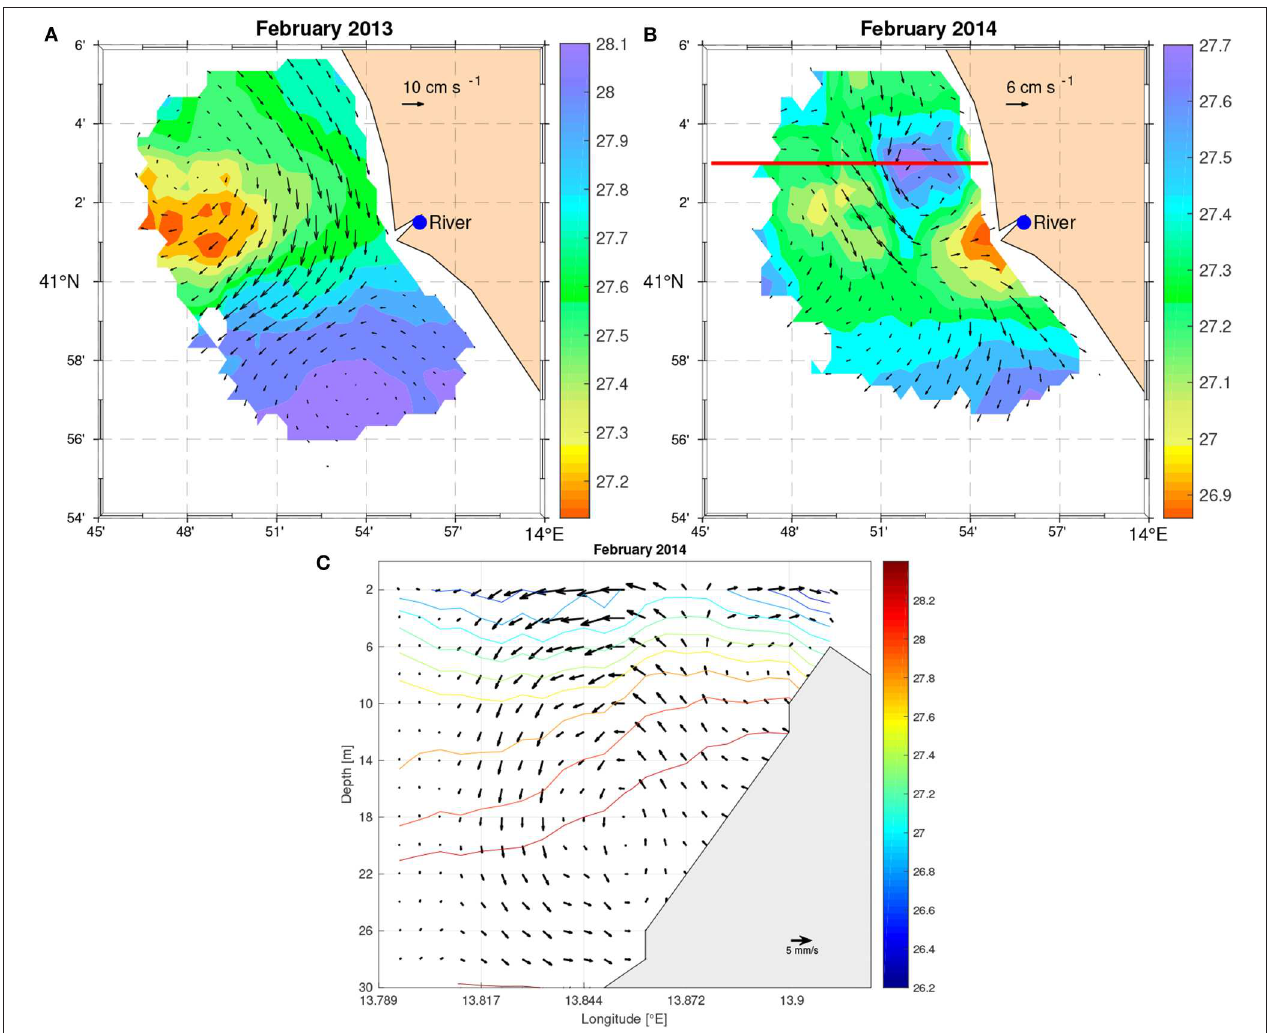
FIGURE 13 | Density and steady circulation at 5 m from the diagnostic numerical experiment using temperature and salinity fields optimally interpolated from the CTDs of February 2013 (A) and in February 2014 (B) . Units are kg m − 3 for density ( σ t ) and cm s − 1 for the total velocity, which are not plotted where the expected error of the OA on the observed temperature and salinity exceeds 20 % . Panel (C) shows the vertical velocities and the density contours at 41 ◦ 03 ′ N (red line in B